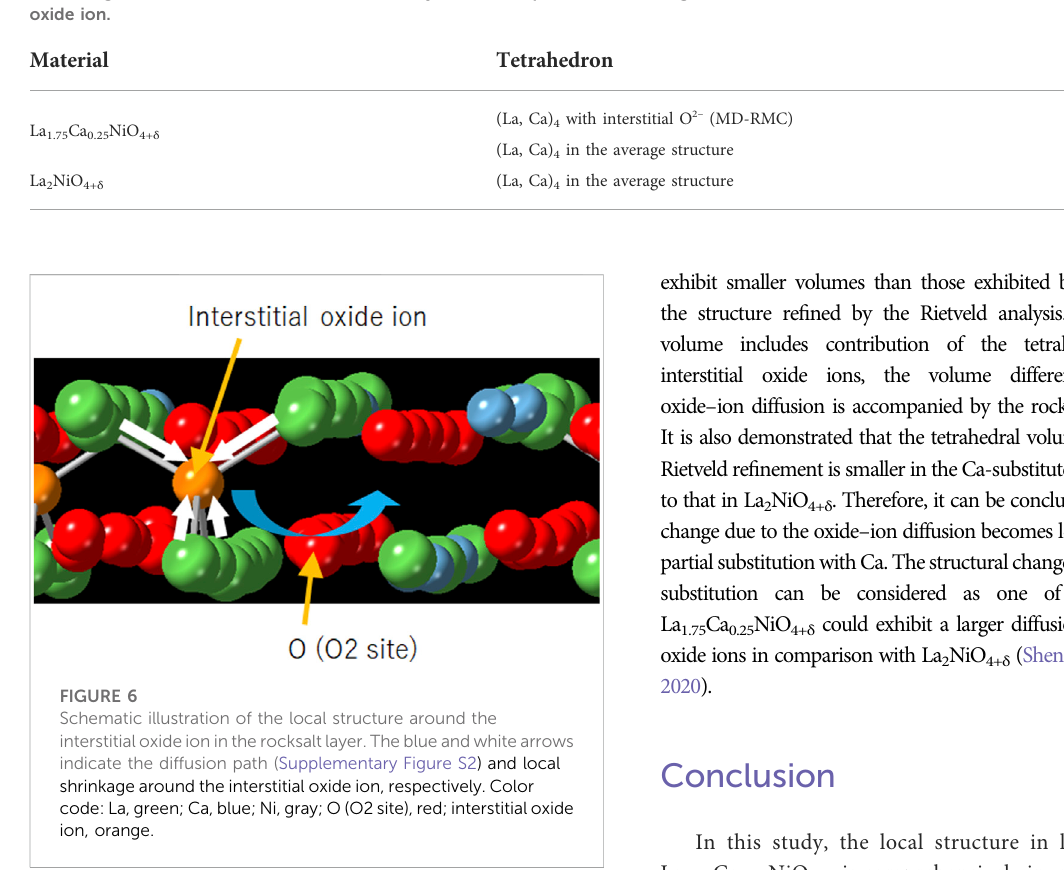
TABLE 2 Volumes of (La, Ca) 4 tetrahedra with the interstitial oxide ion as the central ion. This table also lists the tetrahedral volumes estimated from theaveragestructurere fi nedviatheRietveldanalysis,whichrepresentstheaveragevaluesof(La,Ca) 4 tetrahedrawithandwithouttheinterstitial oxide